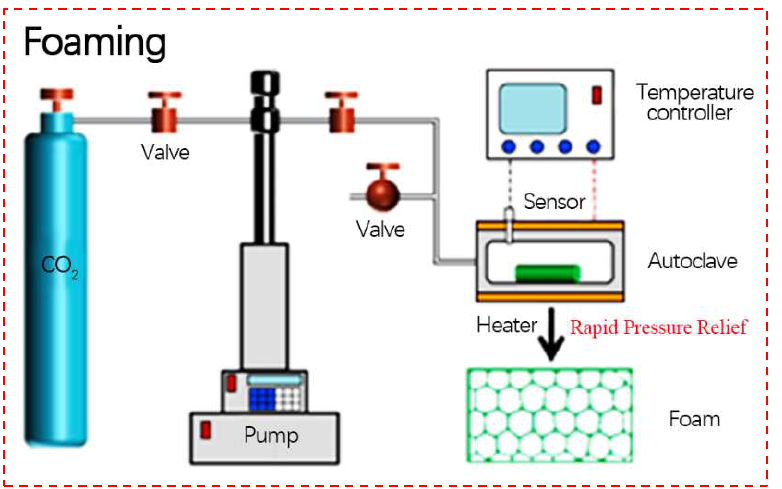
Figure 2. Pressure-induced foaming process (reproduced with permission from Reference [56], Copyright 2022 Elsevier).